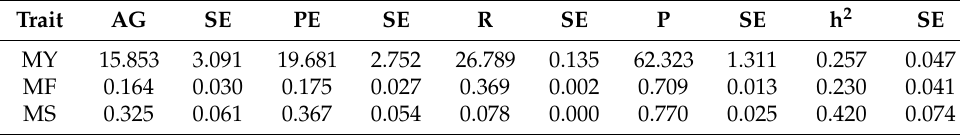
Table 6. Mean daily heritabilities (h 2 ) through the whole 305-d lactation.